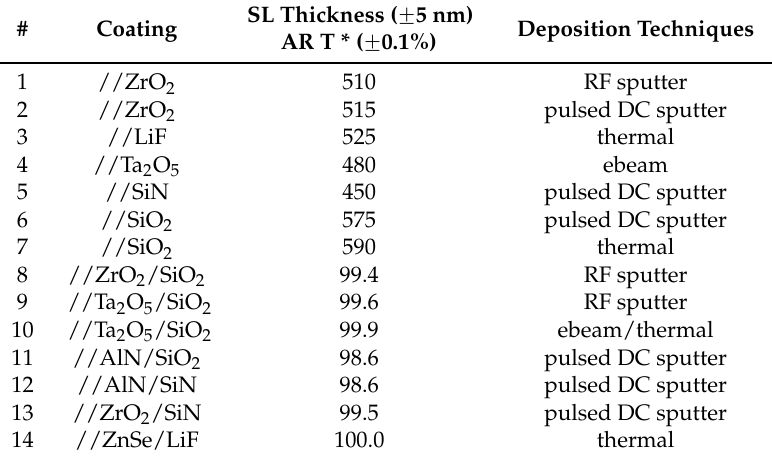
Table 2. Coating material compositions and deposition techniques is given, with measured thicknesses for the single-layer (SL) coatings and transmission (T) values for the anti-reflection (AR)